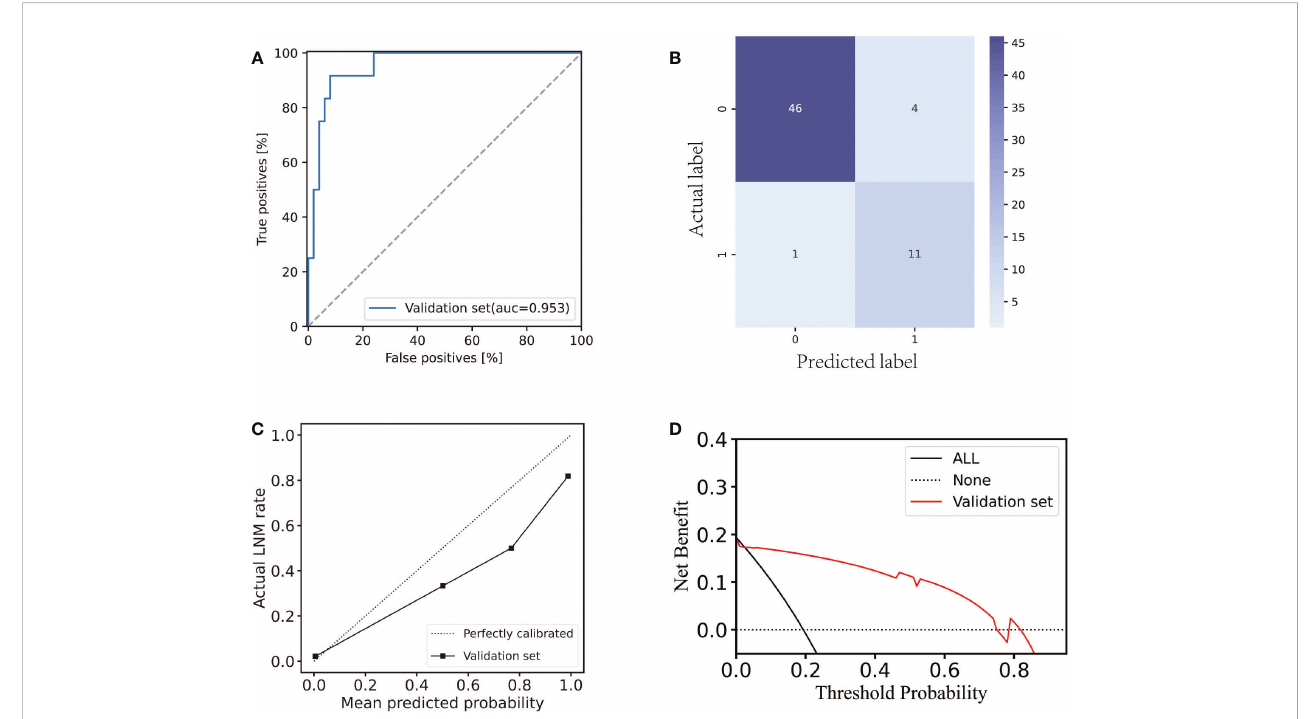
FIGURE 4 Performance of the AS-based model in the validation set. (A) ROC curve of the AS-based model in the validation set. (B) Confusion matrix plot for the AS-based model in the validation set. (C) Calibration plot for the AS-based model in the validation set. (D) Decision curve analysis plot for the AS-based model in the validation